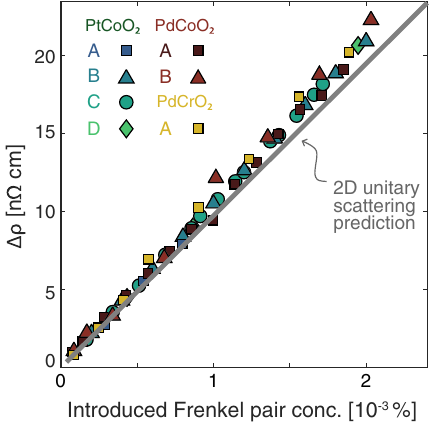
FIG. 10. Resistivity increment of four PtCoO 2 samples, two PdCoO 2 samples and a PdCrO 2 sample as a function of introduced Frenkel pair concentration compared to the unitary scattering